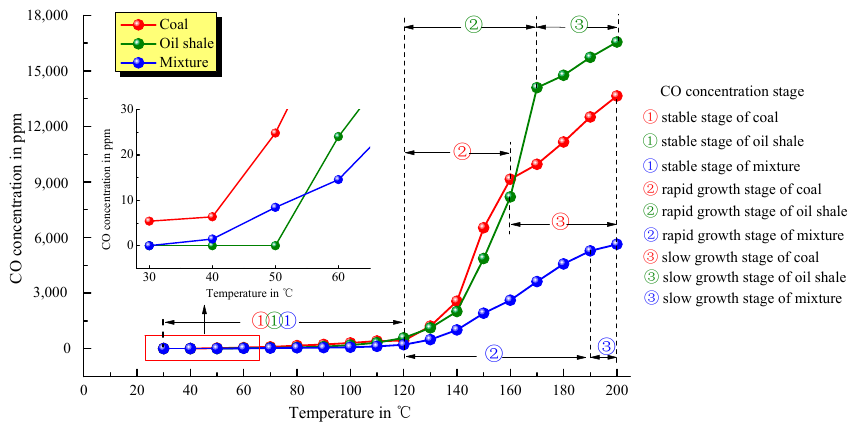
Figure 3. Relationship between CO concentration and temperature.